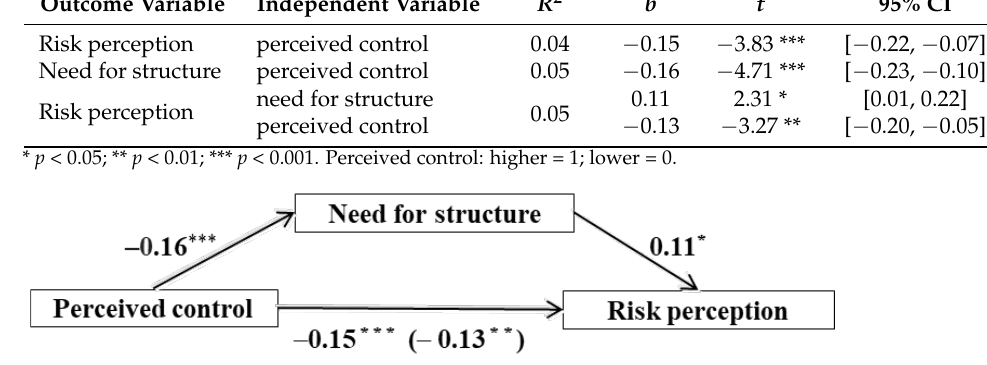
Figure 3. Mediation model. N = 401; * p < 0.05; ** p < 0.01; *** p <